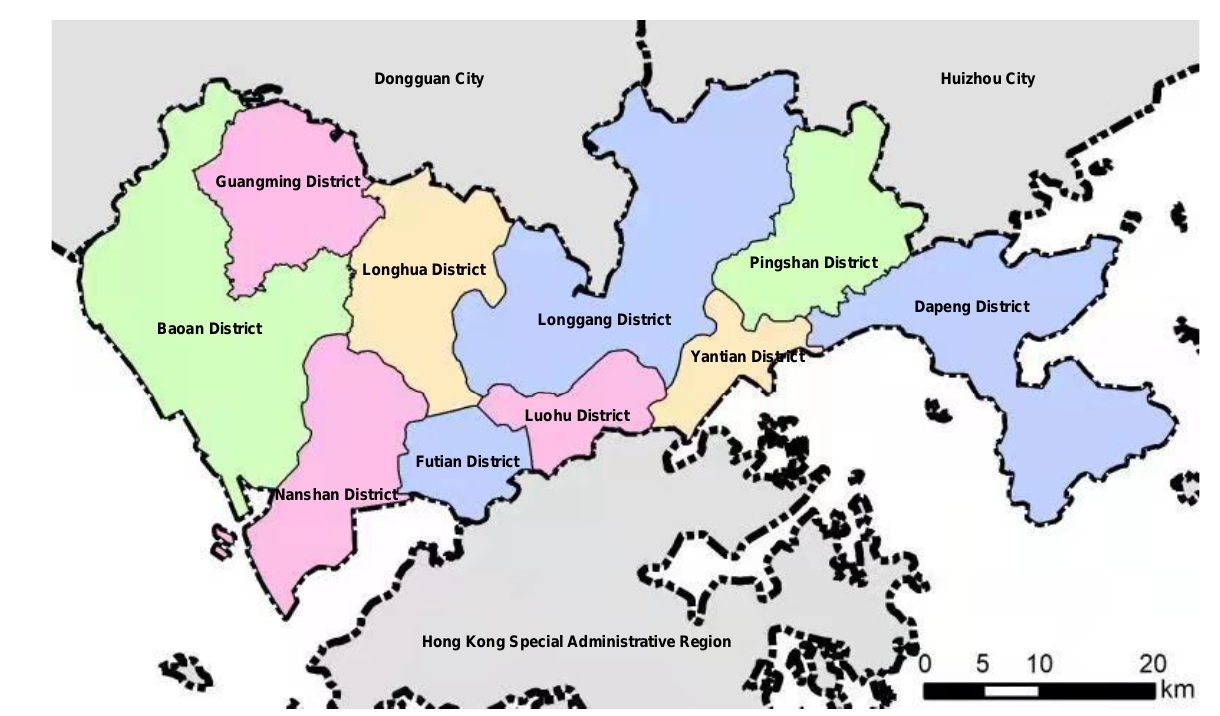
Figure 2. The location of Nanshan District.